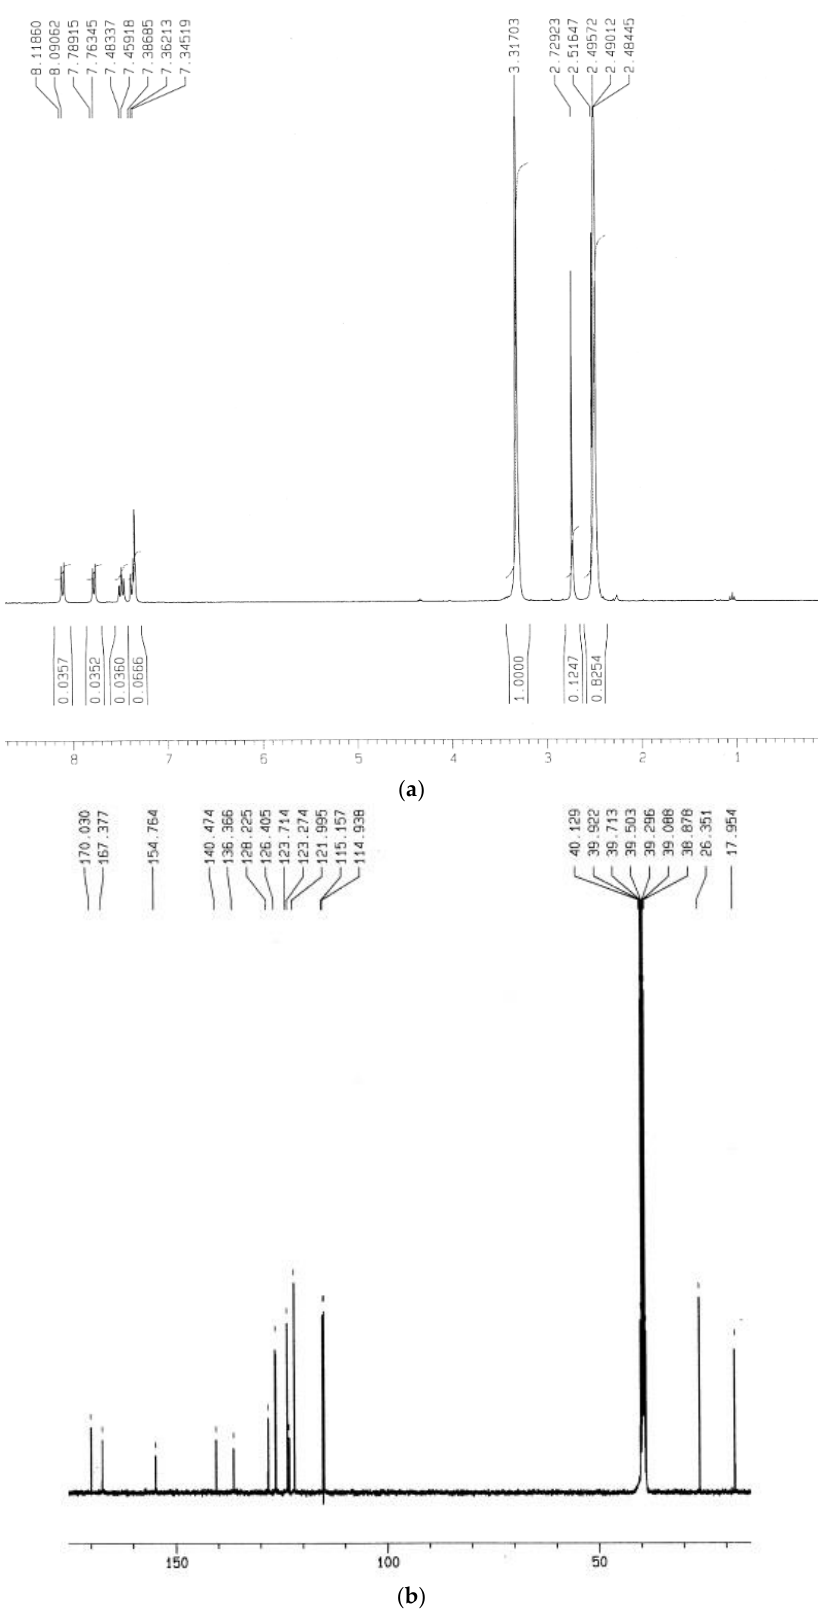
Figure 1. ( a ) 1 H-NMR and ( b ) 13 C-NMR spectrum analysis